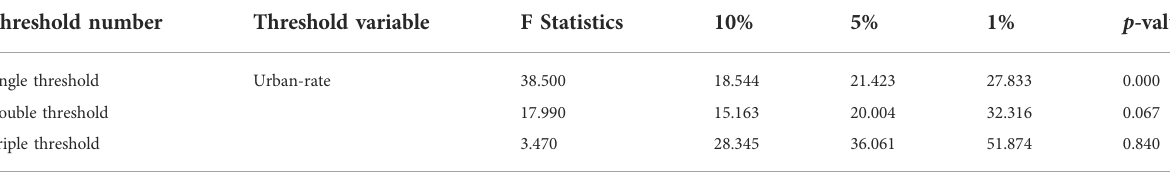
TABLE 7 Threshold effect existence test with Urban-rate as the threshold variable.